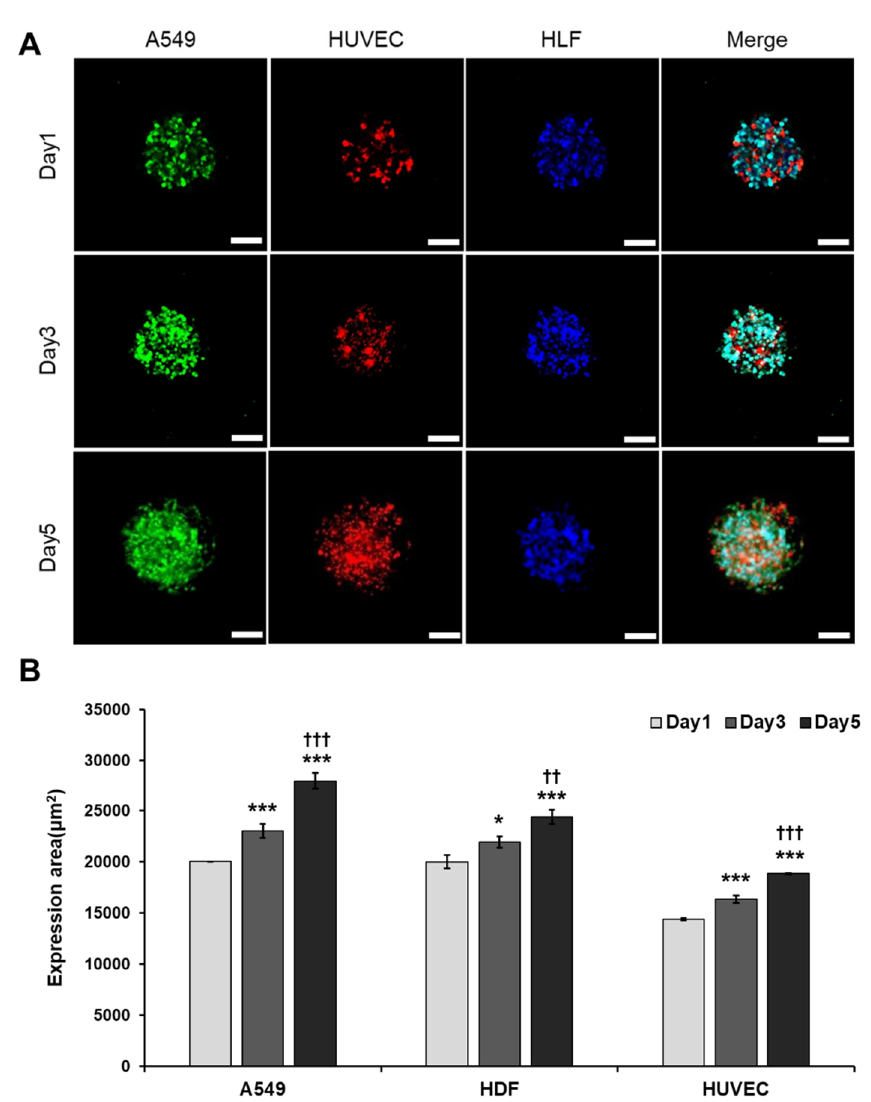
Figure 4. Optimization of tumor spheroid formation. ( A ) Fluorescent image of tri-cellular spheroids at 1, 3 and 5 days after seeding. Scale bar: 100 µ M. ( B ) Quantification of expression area of A549 cells, HUVECs and HLFs. * p < 0.05, *** p < 0.005 compared with Day 1, †† p < 0.01, ††† p < 0.005 compared with Day 3.